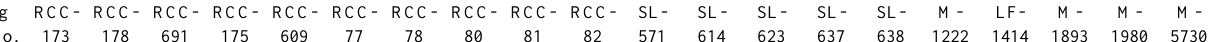
Table 3. Estimation of pair wise genetic distance between experimental cattle populations using Nei and Li’s (1979) equation Tag RCC- RCC- RCC- RCC- RCC- RCC- No. 173 178 691 175 609